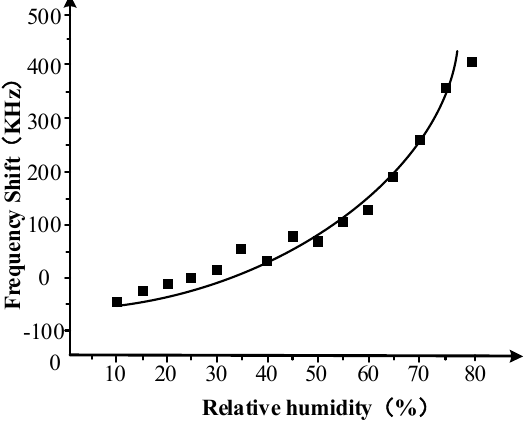
Figure 10. Frequency shift of the sensor change with the relative humidity.